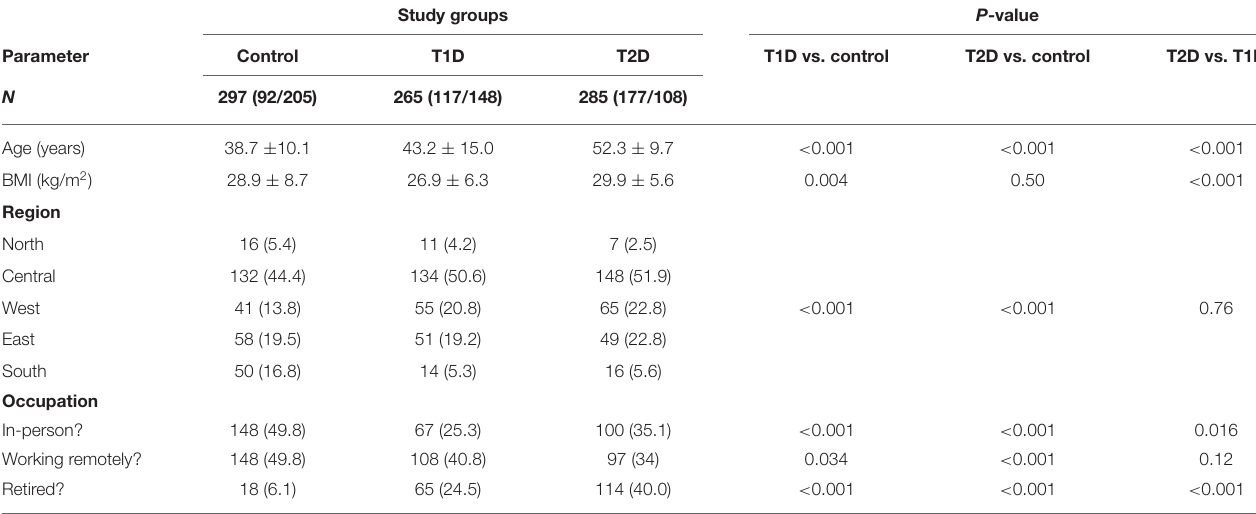
TABLE 1 | Anthropometric and demographic differences in the study